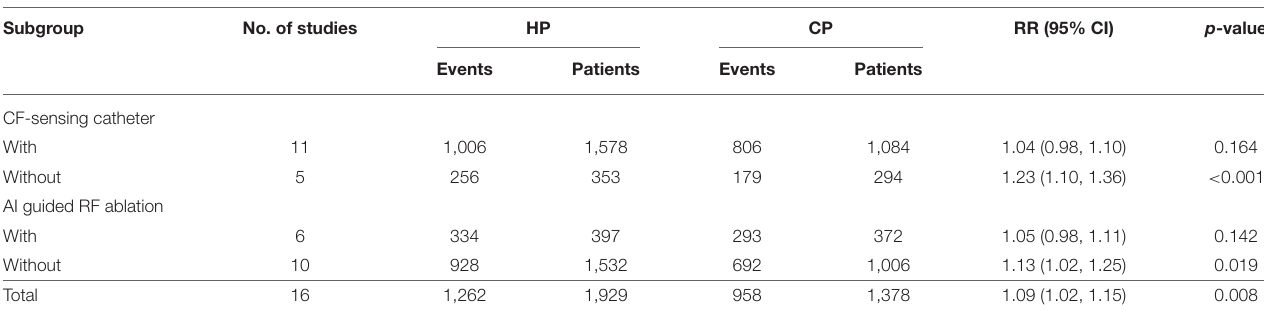
TABLE 4 | Subgroup analysis of AF/atrial tachycardia-free survival.